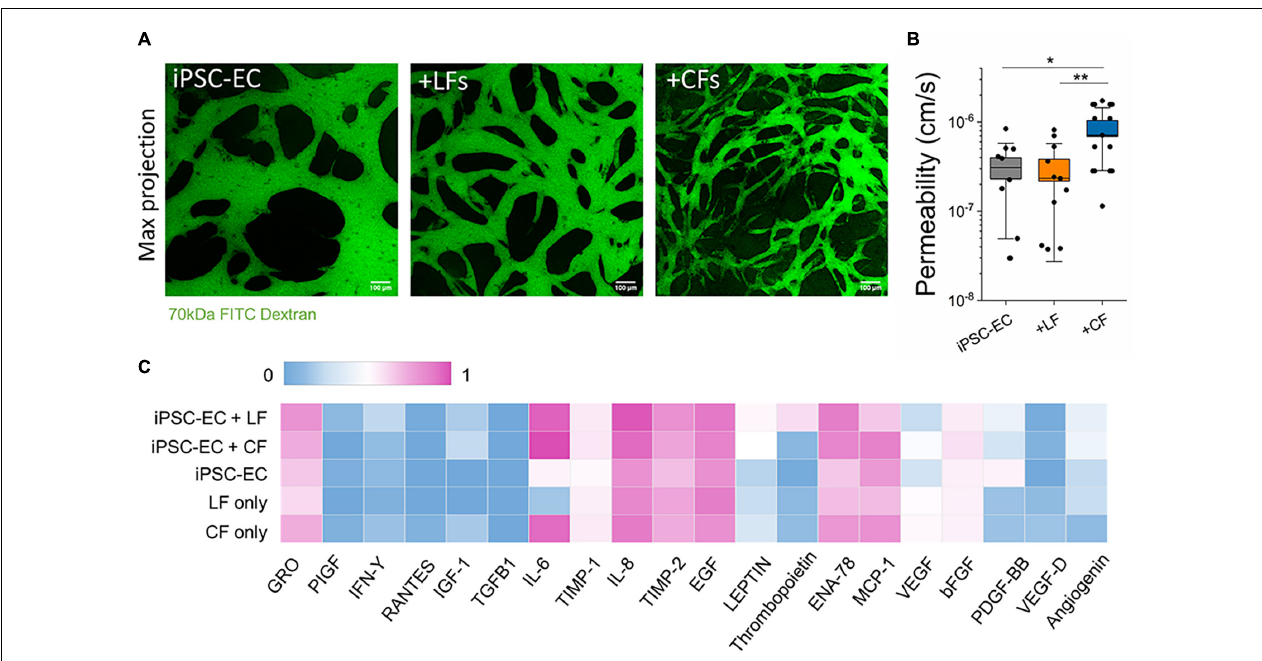
FIGURE 2 | Endothelial barrier function is affected by stromal cells. (A) Confocal maximum projection images demonstrating microvessels perfused with 70 kDa FITC dextran (green). The scale bar is 100 µ m. (B) Endothelial permeability to 70 kDa FITC dextran, measured at day 7. CF co-culture significantly decreases endothelial barrier function. Shown are data from 3 separate experiments. Box plots demonstrate SD (outer whiskers) and SE (box edge). Significance is shown by * P < 0.05, ** P < 0.01 using a t -test to compare with mono-cultured and co-cultured vessels. (C) Cytokine profiling using an antibody array from supernatant collected from microvessels at day 5. The measured intensity of the expressed cytokines was normalized intensity to the positive and negative controls on the